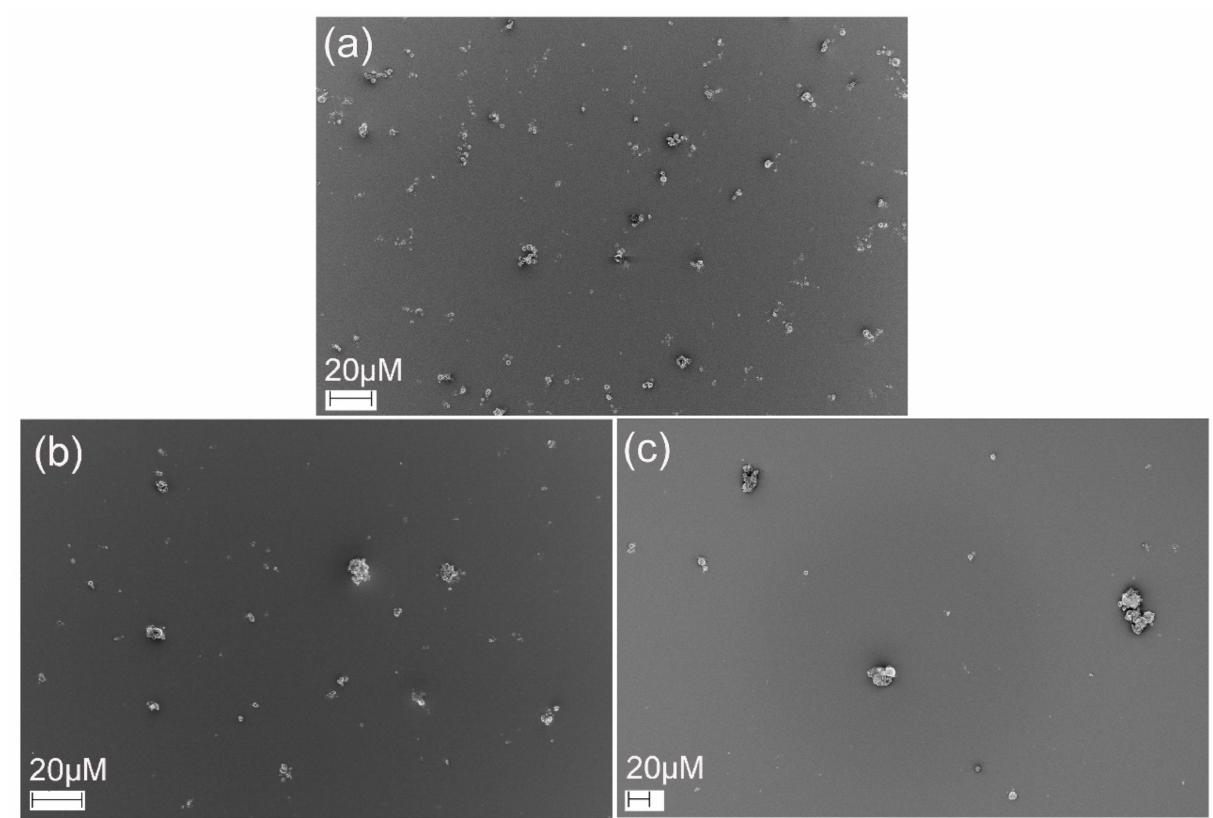
Figure 10. SEM images of HAGA ( a ), HAUR ( b ) and HA ( c ) microparticles deposited using mACI at a 60 L min − 1 air flow